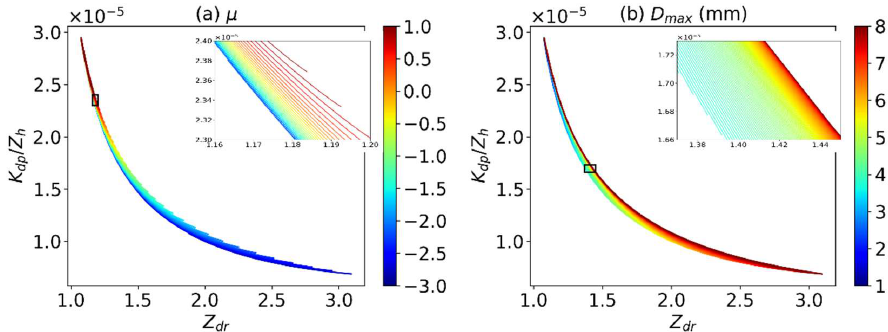
Figure 6. Simulations of Z dr and K dp /Z h on linear scales: ( a ) the colored curves represent a number of fixed µ ; and ( b ) the colored curves represent a number of fixed D max